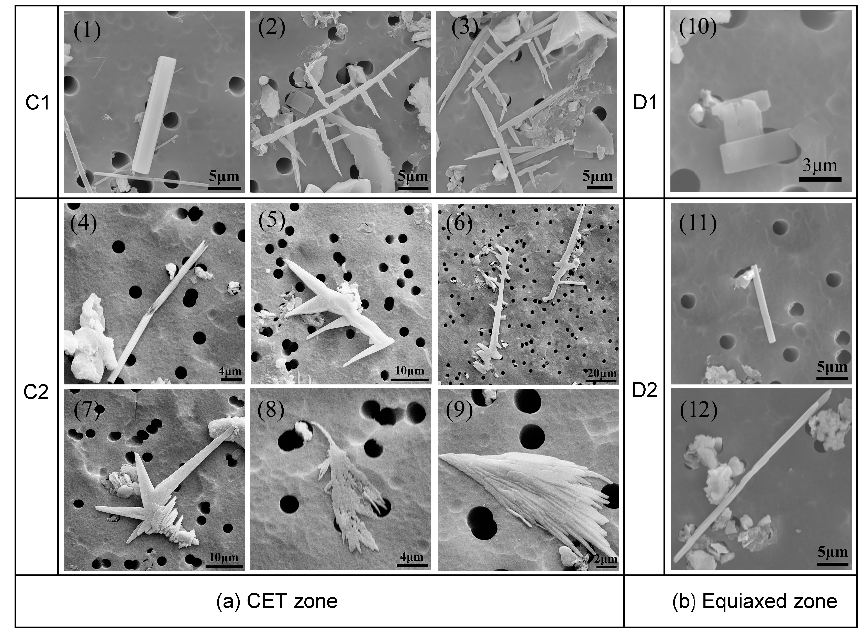
Figure 6. Typical morphologies of CaS inclusion in CET zone ( a ) and equiaxed zone ( b ). (1), (4), (11) and (12) are rod-like CaS; (2), (3), (5) and (6) are dendrite-like CaS; (7), (8) and (9) are irregular-shaped CaS; (10) is sheet-like CaS.